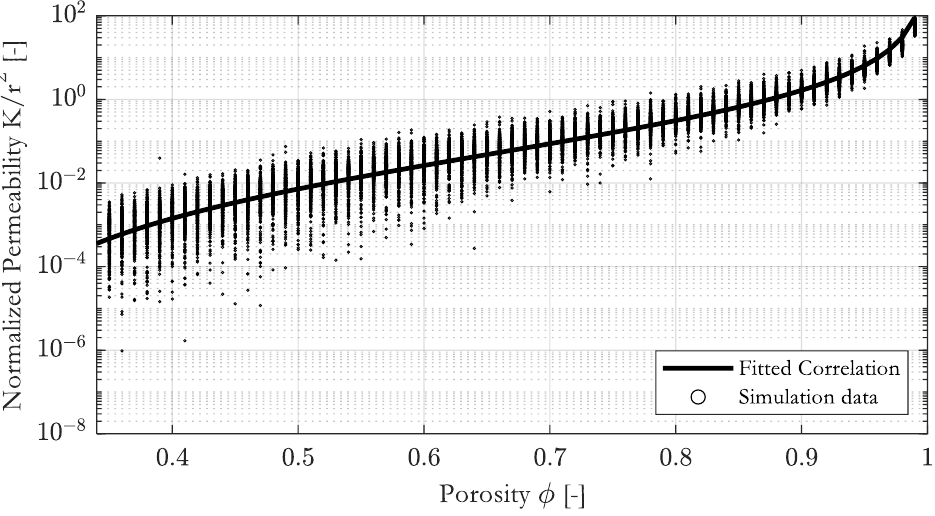
Figure 9. Constitutive permeability – porosity correlation and simulation data.